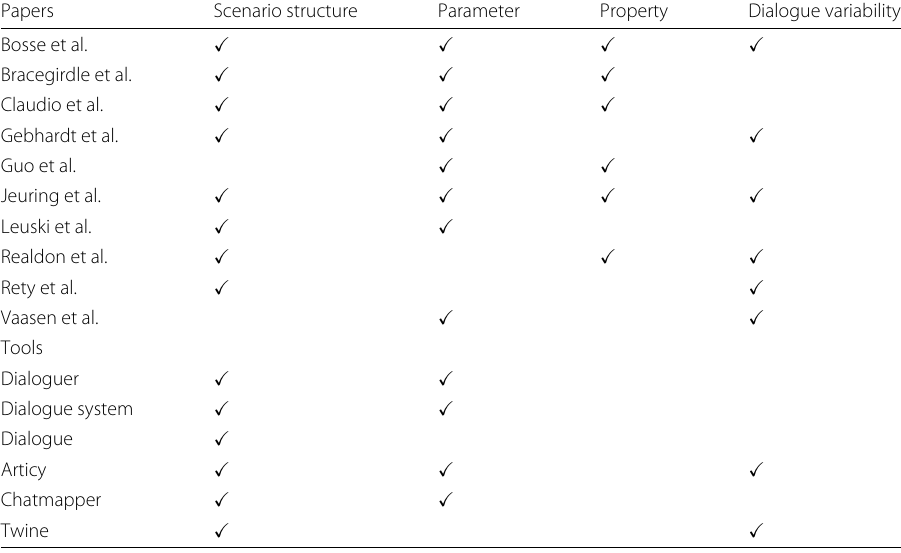
Table 1 Which concepts are used where?